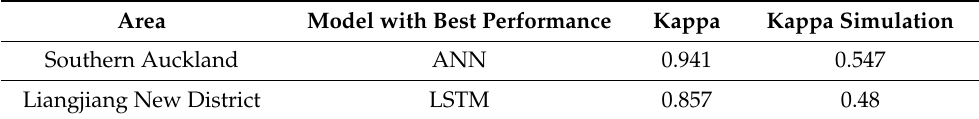
Table 4. Model validation results between southern Auckland and Lianjiang New